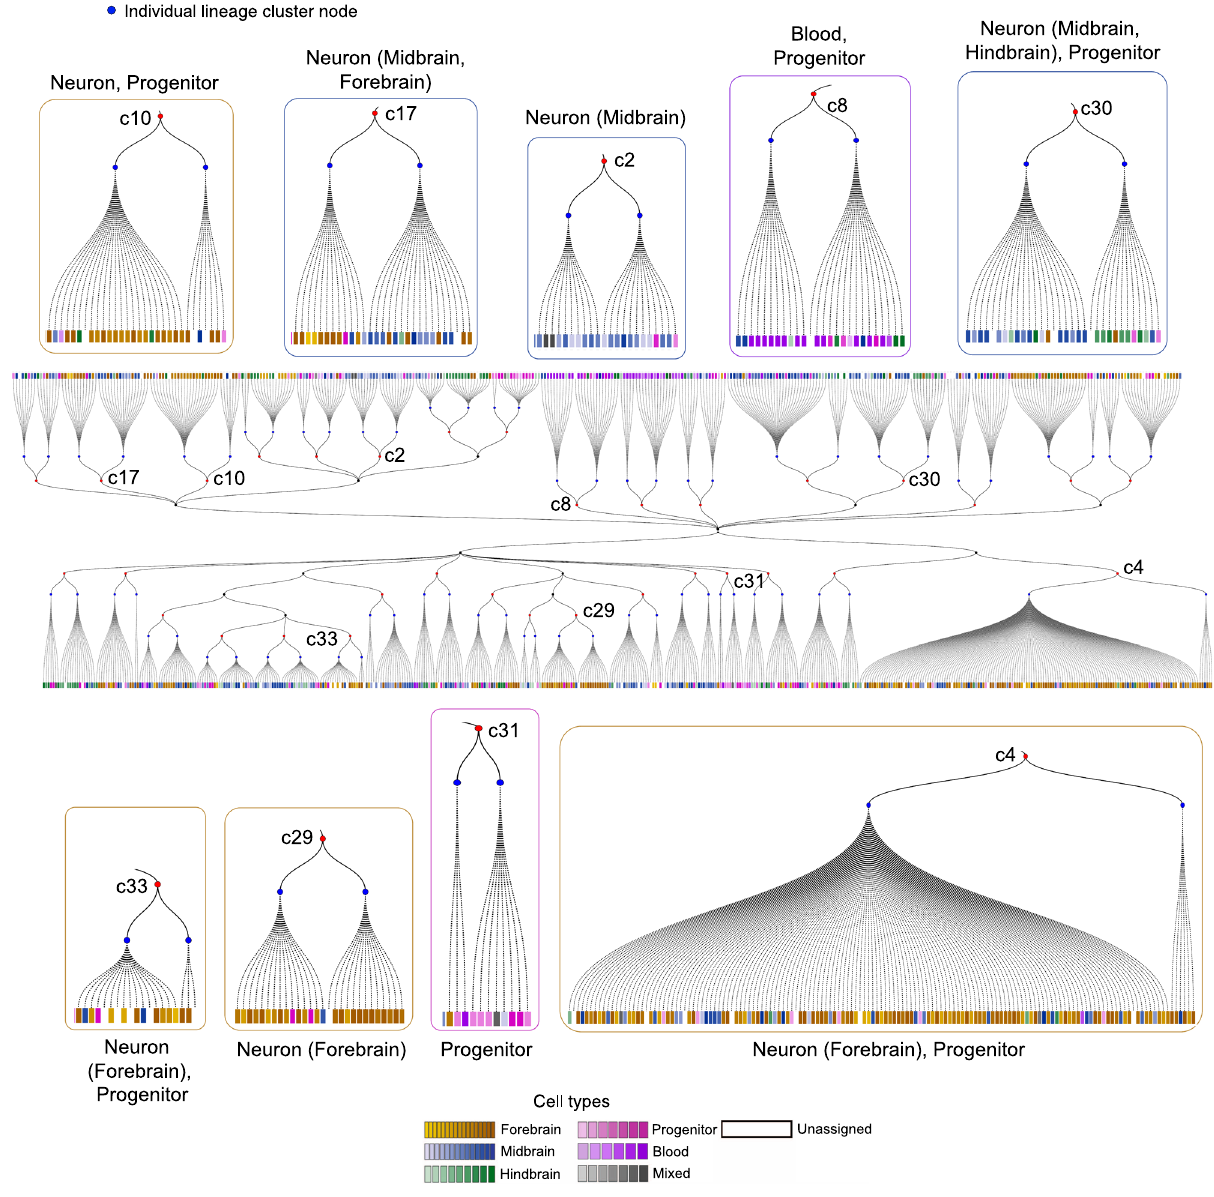
Fig. 4 Invariant lineage tree for juvenile zebra fi sh brain for scGESTALT dataset. The two-sided tree in the middle represents the invariant lineage tree generated by LinTIMaT by combining the individual trees for ZF1 and ZF3. Blue nodes here represent the clusters from individual fi shes (left node: ZF1, right node: ZF3), and red nodes represent the matched invariant clusters. Each leaf node is a cell, represented by a square, and its color represents its cell type as indicated in the legend. Subtrees illustrate examples of invariant clusters preserved in the individual lineage